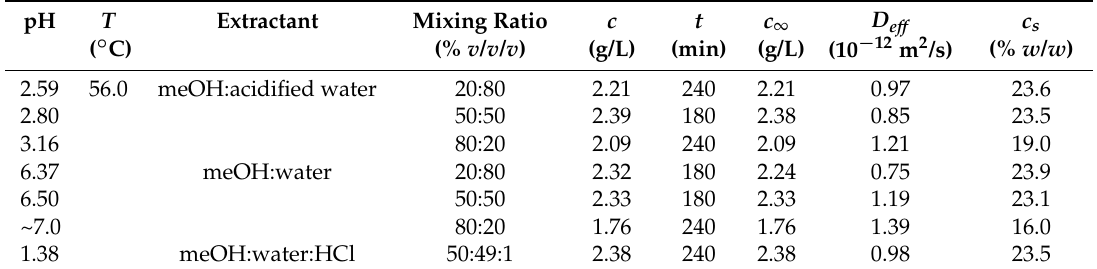
Table 4. Release data using different solvents.